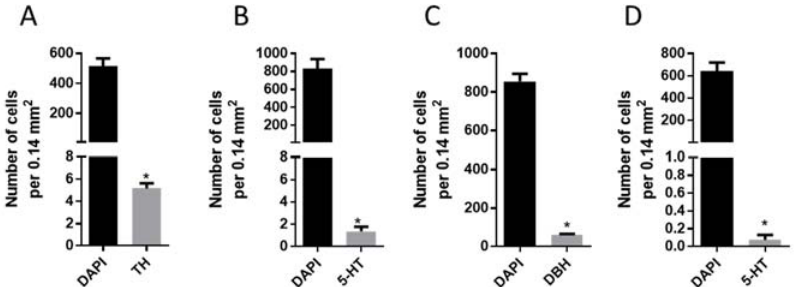
Figure 3. Mean number of all cells labeled with DAPI-stained nuclei in a primary culture of mesencephalon ( A , B ) and metencephalon ( C , D ) in mice in randomly selected culture areas of 0.14 mm², as well as the average number of mesencephalic neurons immunopositive for tyrosine hydroxylase (TH) ( A ) or 5-hydroxytryptamine (5-HT) ( B ), as well as of metencephalic neurons immunopositive for dopamine- β -hydroxylase (DBH) ( C ) or 5-HT ( D ). * p < 0.05.